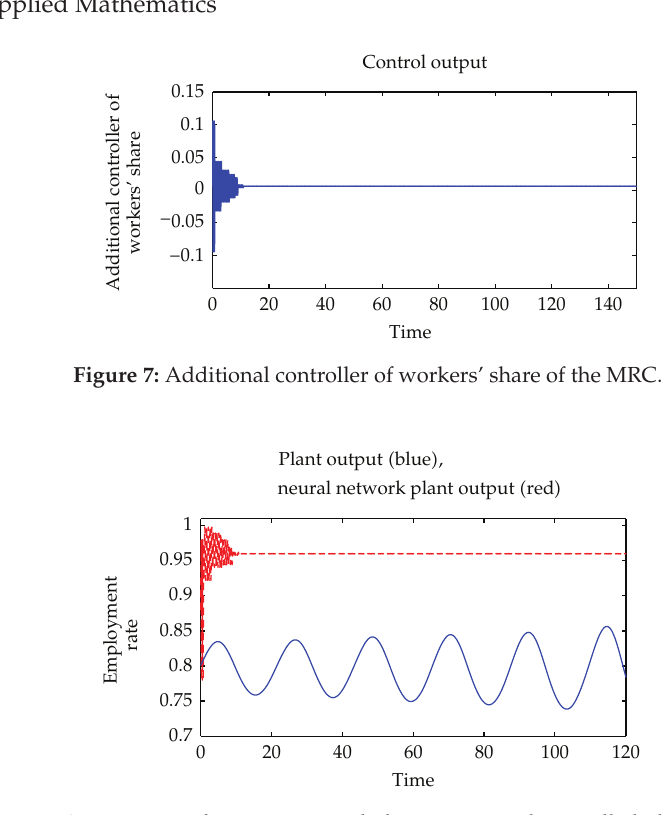
Figure 8: A comparison between original plant output and controlled plant